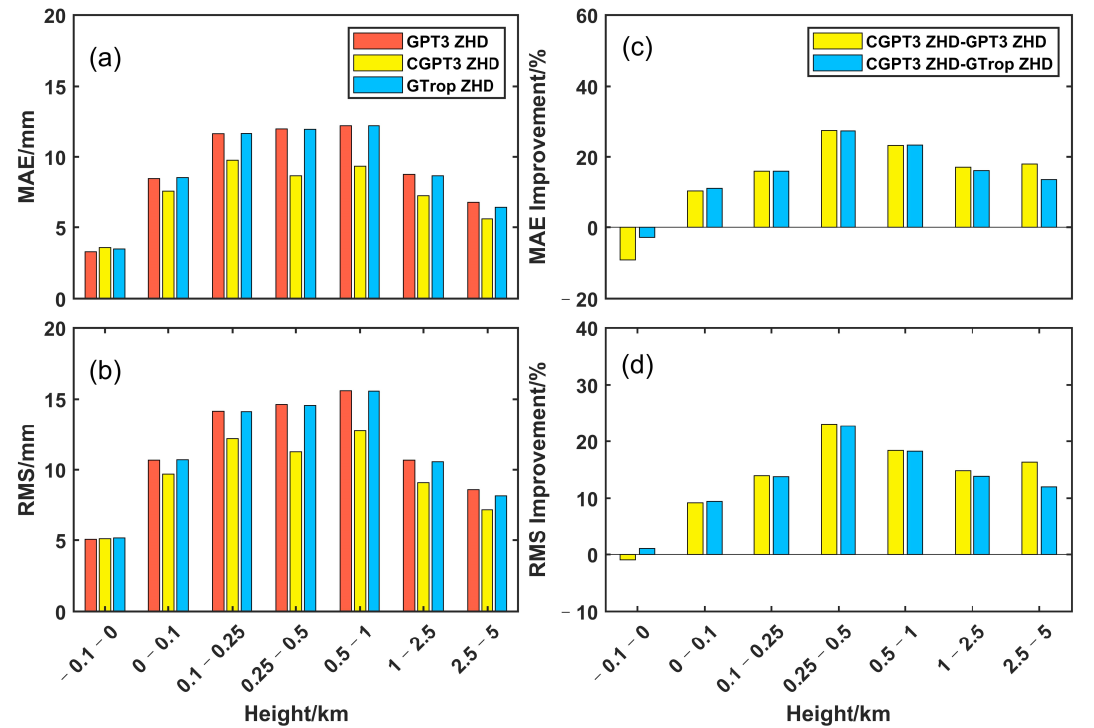
Figure 6. Variation of MAE and RMS with height ( a , b ) and improvement rates of the absolute values of MAE and RMS ( c , d ) of ZHD derived from the three models.